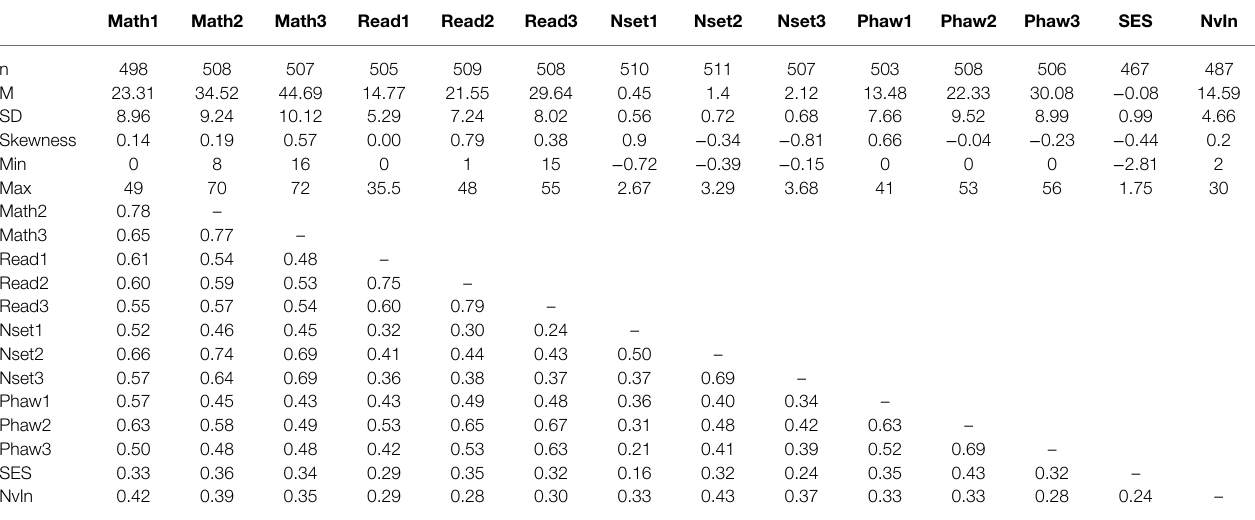
TABLE 1 | Descriptive statistics (top) and age-adjusted bivariate correlation table (bottom). Math1